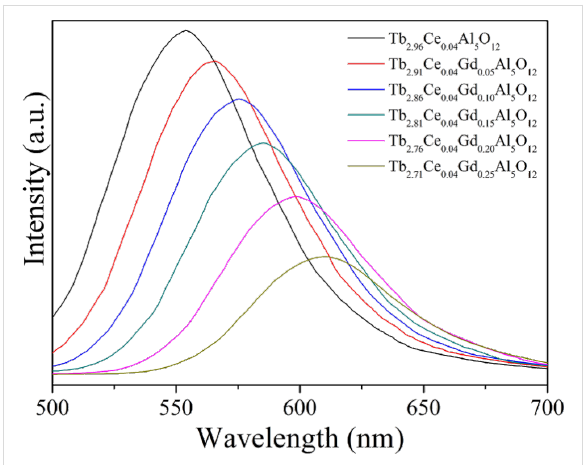
about 554 nm. For the Tb 2.71 Ce 0.04 Gd 0.25 Al 5 O 12 phosphor, the